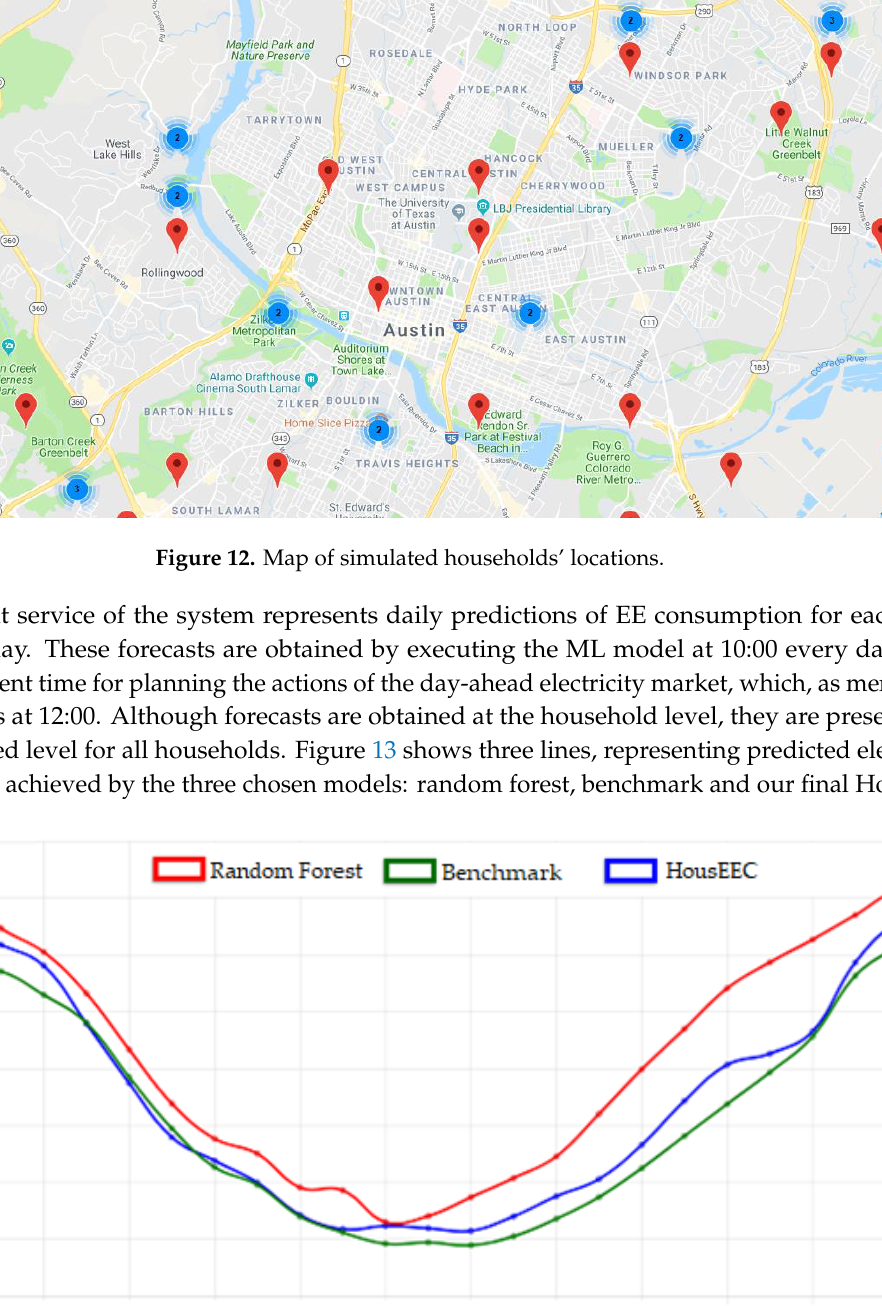
20 of 30 Table 7. Comparison of performance of general and HousEEC models. Method